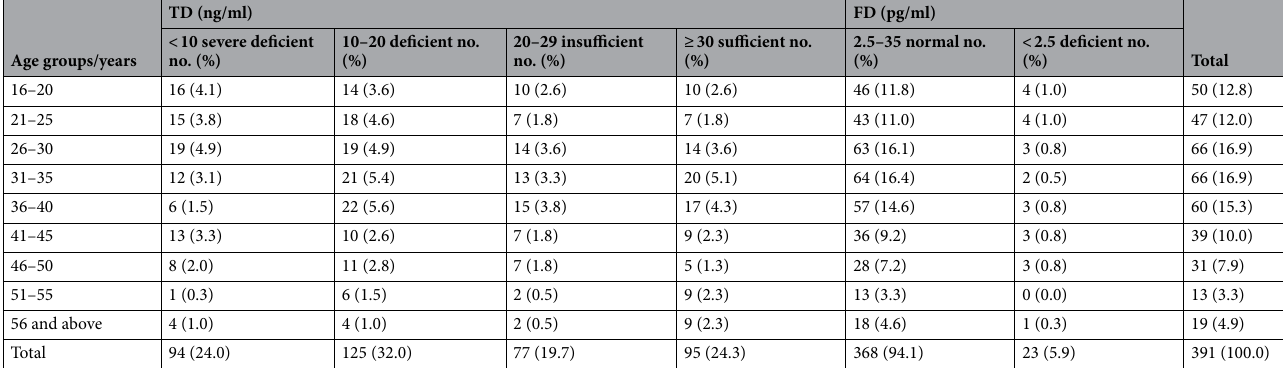
Table 2. Total 25-OHD and Free 25-OHD levels in respect to age groups. P-value of TD = 0.297, P-value of FD = 0.846.